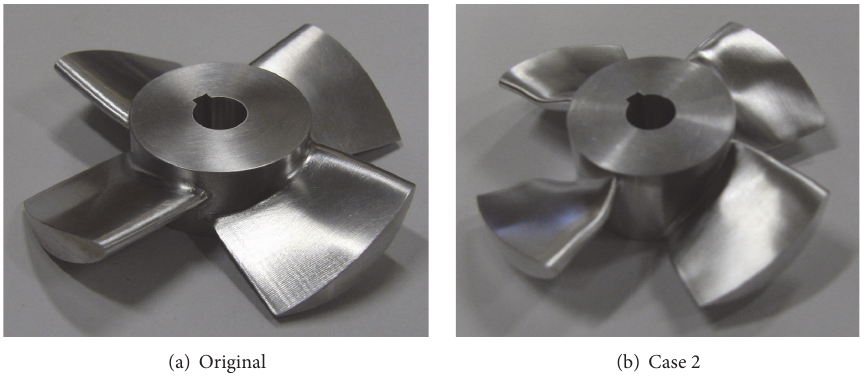
Figure 13: Actual device of the runner.